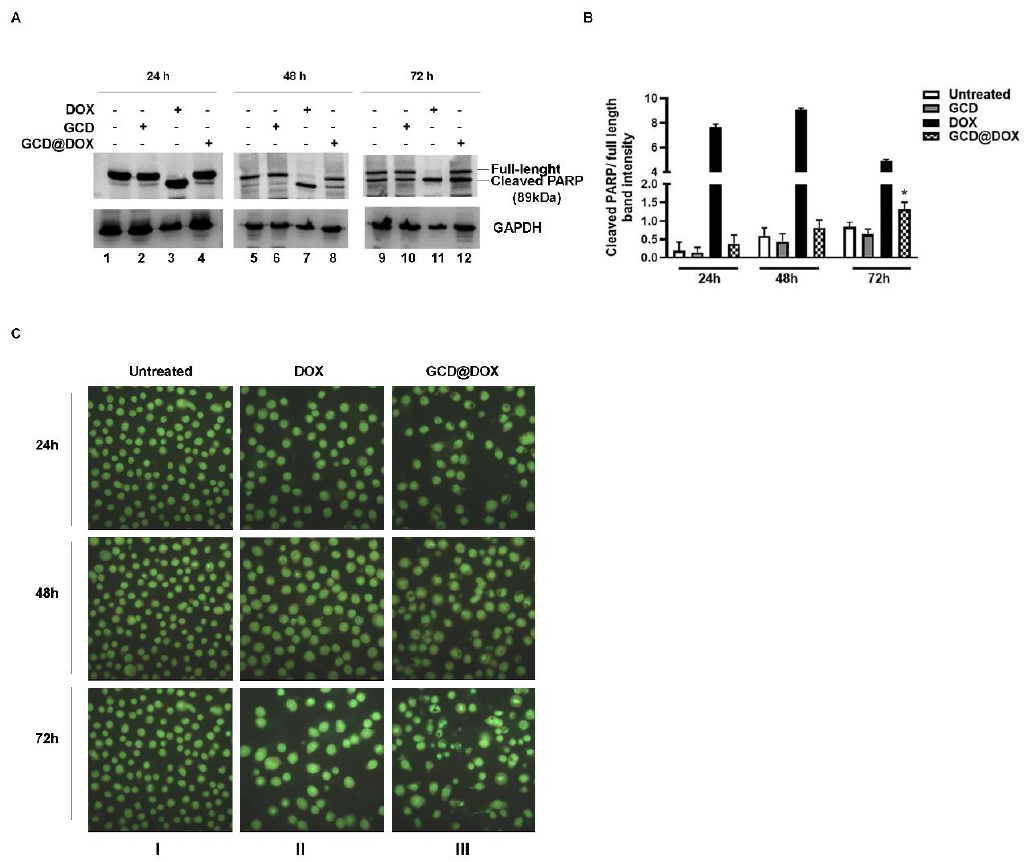
Figure 4. Monitoring of apoptosis in HEp-2 cells following DOX, GCD and GCD@DOX treatment. HEp-2 cells were untreated and treated with 1.25 µ g/mL of DOX and 25 µ g/mL of GCD@DOX and GCD and collected at 24 h, 48 h and 72 h post-treatment. ( A , B ) The Western blot analysis was performed to detect PARP protein expression. The protein bands were visualised by using Immobilon Classico Western HRP substrate (Merk, Millipore) and captured using a ChemiDoc Touch Imaging System (Bio-Rad). The quantitative densitometry analysis of cleaved PARP/full length band intensity was performed by using ImageJ software and is graphically represented in ( B ) using GraphPad Prism 6 software (GraphPad Software, San Diego, CA, USA). * p < 0.05, compared with the GCD treated cells. ( C ) The morphological analysis of apoptotic cells was performed following staining with the fluorescent DNA-binding dyes acridine orange, at 24 h, 48 h and 72 h post-treatment (I: untreated; II: DOX; III: GCD@DOX) and visualised by fluorescence microscope (Leitz, Wetzlar, Germany) (magnification, 63 ×